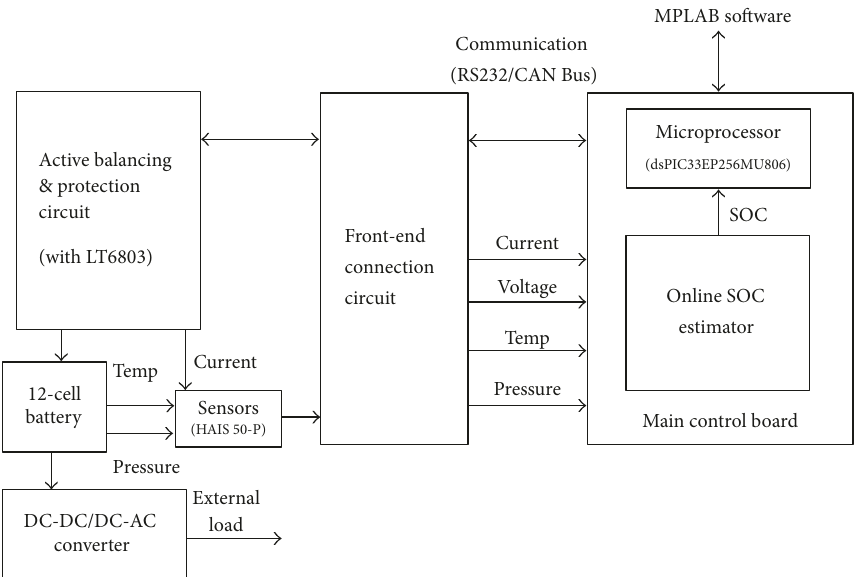
Figure 2: Proposed battery management system architecture with several subsystems for SOC estimation and active cell